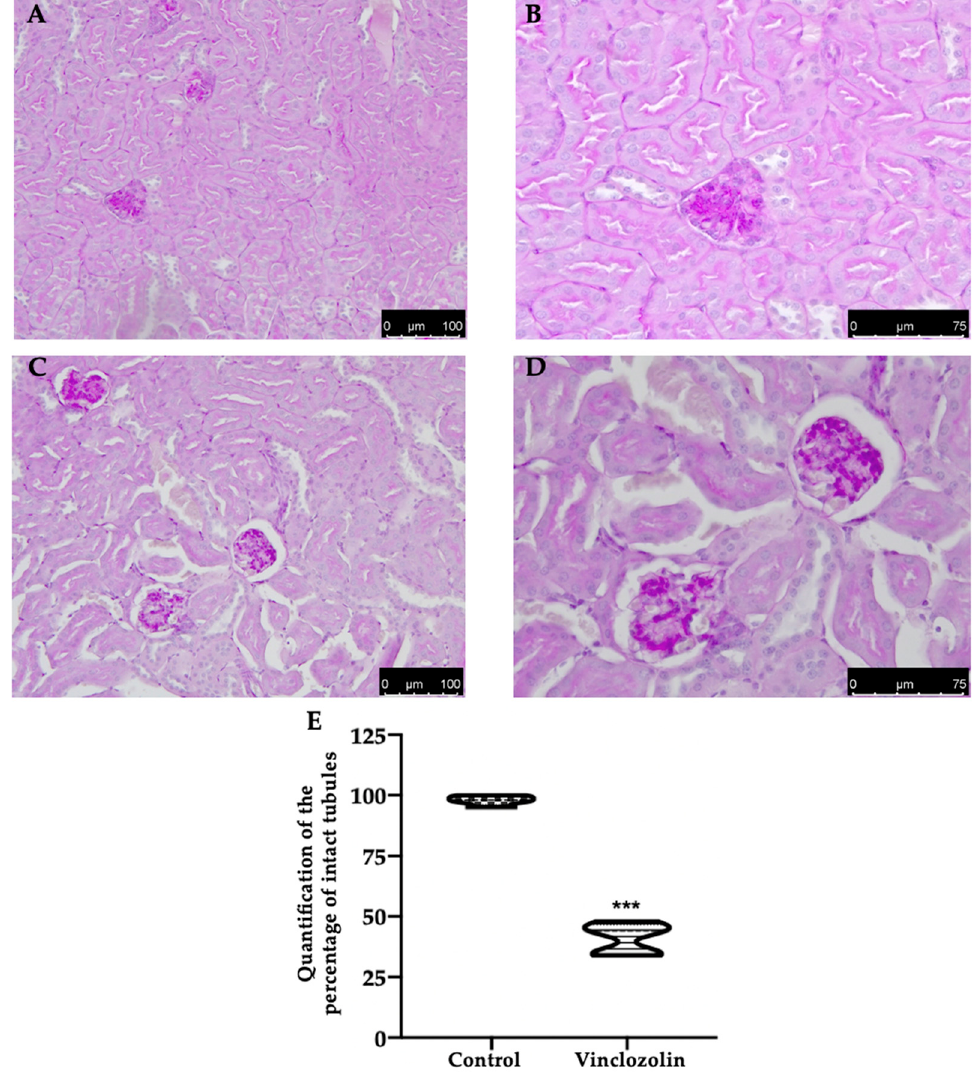
Figure 3. Effects of vinclozolin exposure on kidney histology: PAS staining: ( A ) control magnification 20×; ( B ) control magnification 40×; ( C ) vinclozolin magnification 20×; ( D ) vinclozolin magnification 40×; ( E ) intact tubules %. A p -value less than 0.05 was considered significant. *** p < 0.001 vs. control.